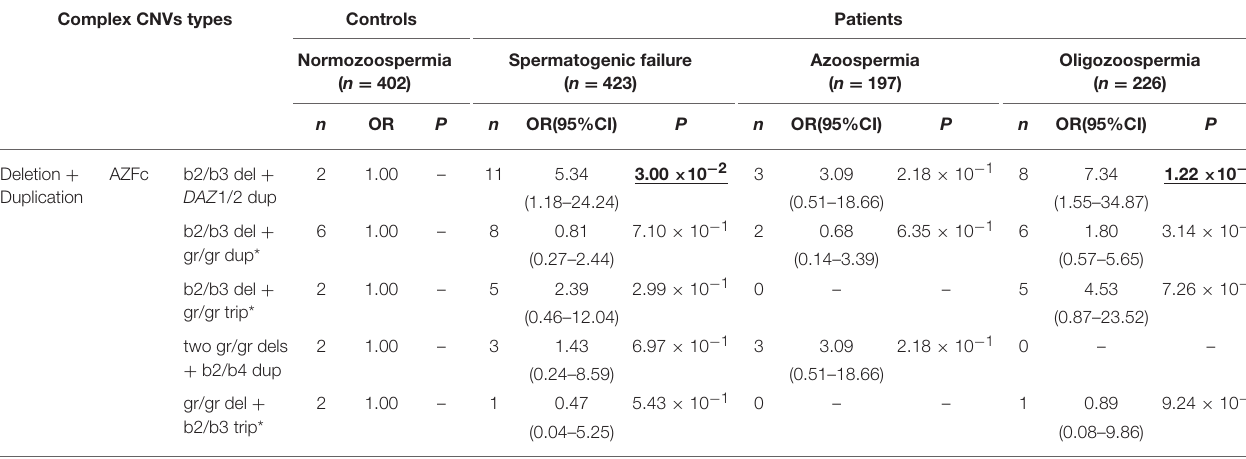
TABLE 4 | Distribution of known and novel complex CNVs (Deletion + Duplication) in AZF regions and their effects on SF.